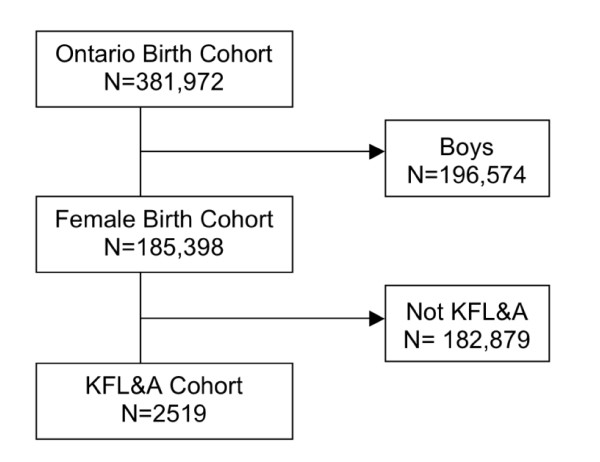
Cohort flow diagram.